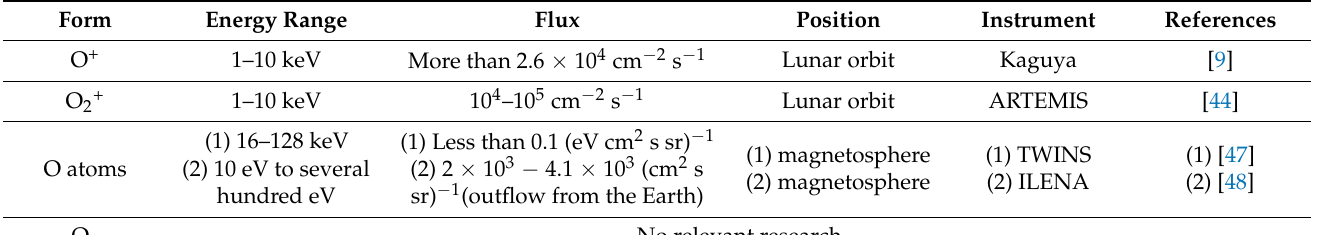
Table 1. The form of oxygen in the Lunar orbit or